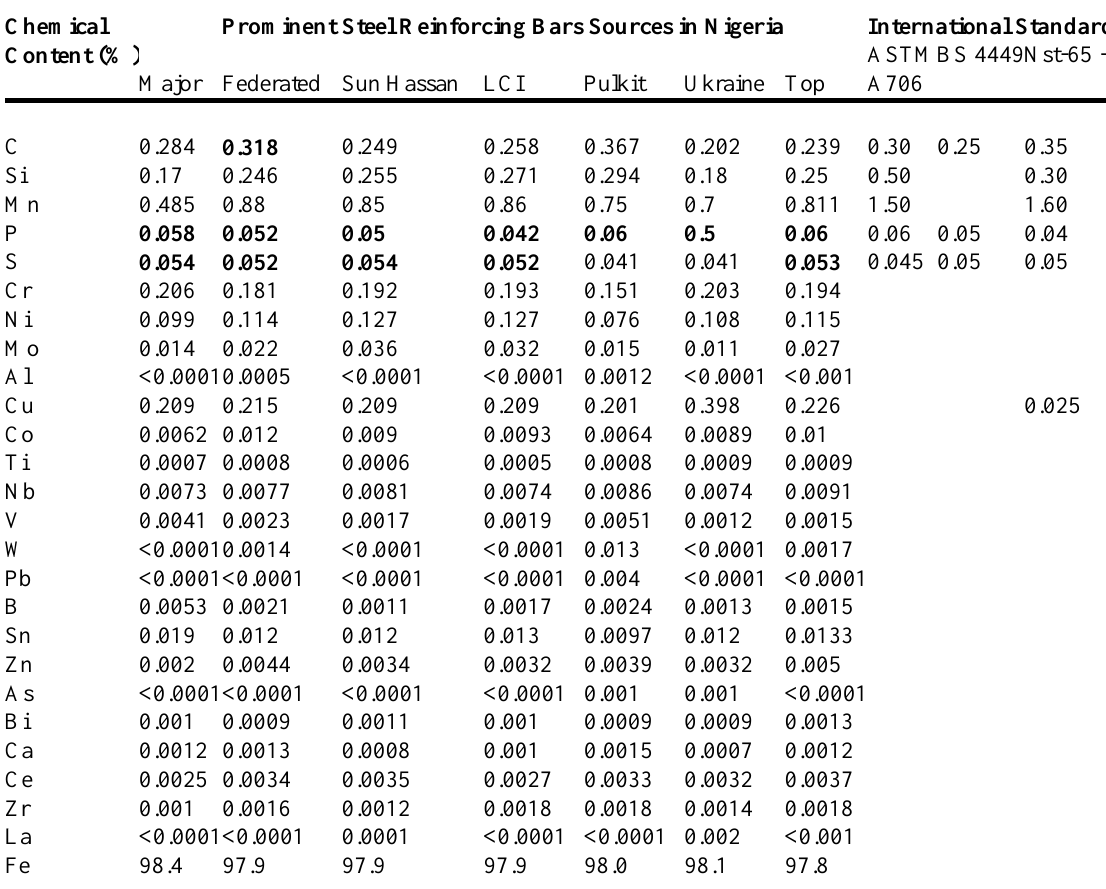
Chemical analysis of steel reinforcing bar